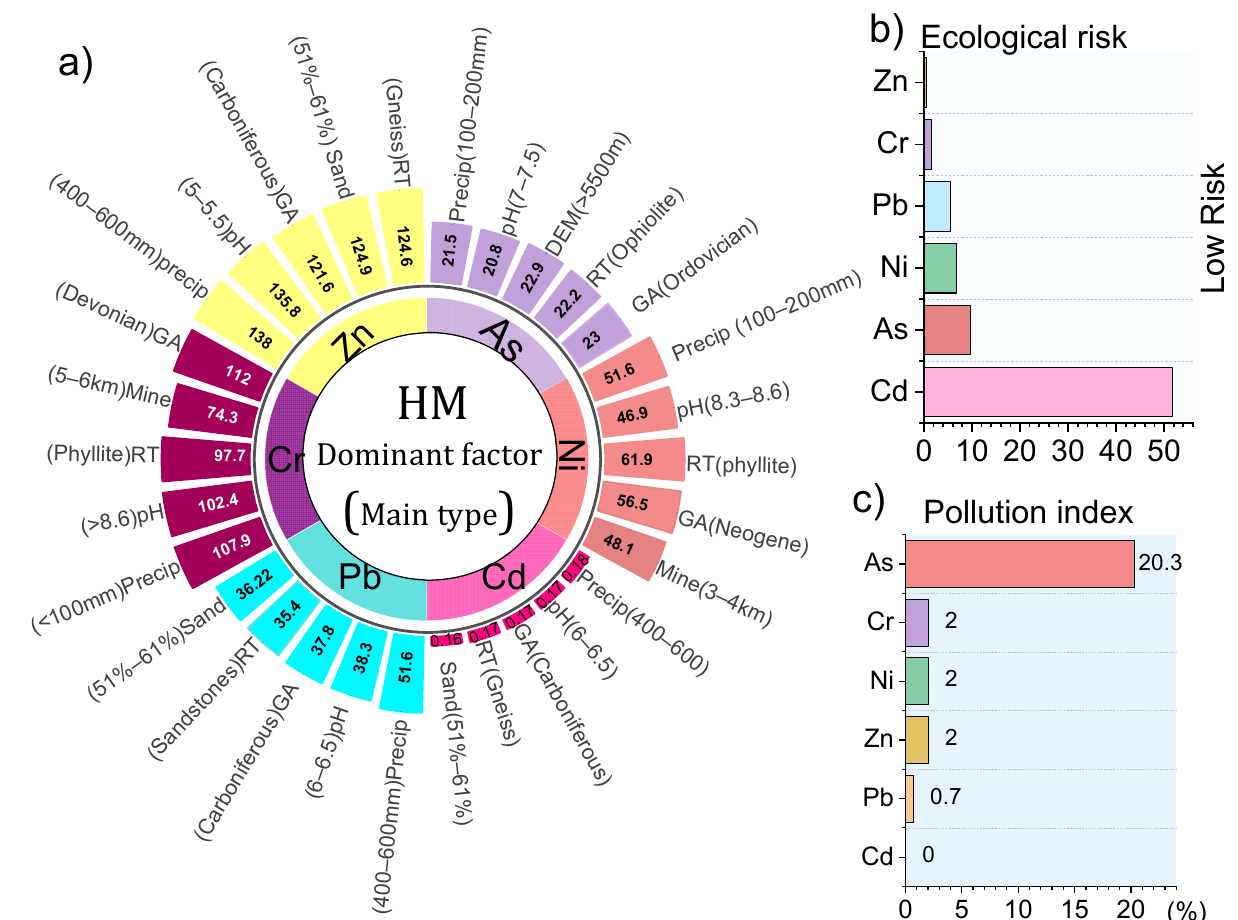
Figure 7. Risk characteristics of HMs in YTRB. ( a ): The key influential types (ranges) of the dominant factors and their effects on the enrichment of the HM concentration. The number represents the highest average concentration (mg/kg) of HM in each type (range) of the dominant factors. ( b ): Eco- logical risk assessment of heavy metals based on traditional models. ( c ): Pollution index assessment of HMs based on traditional models.